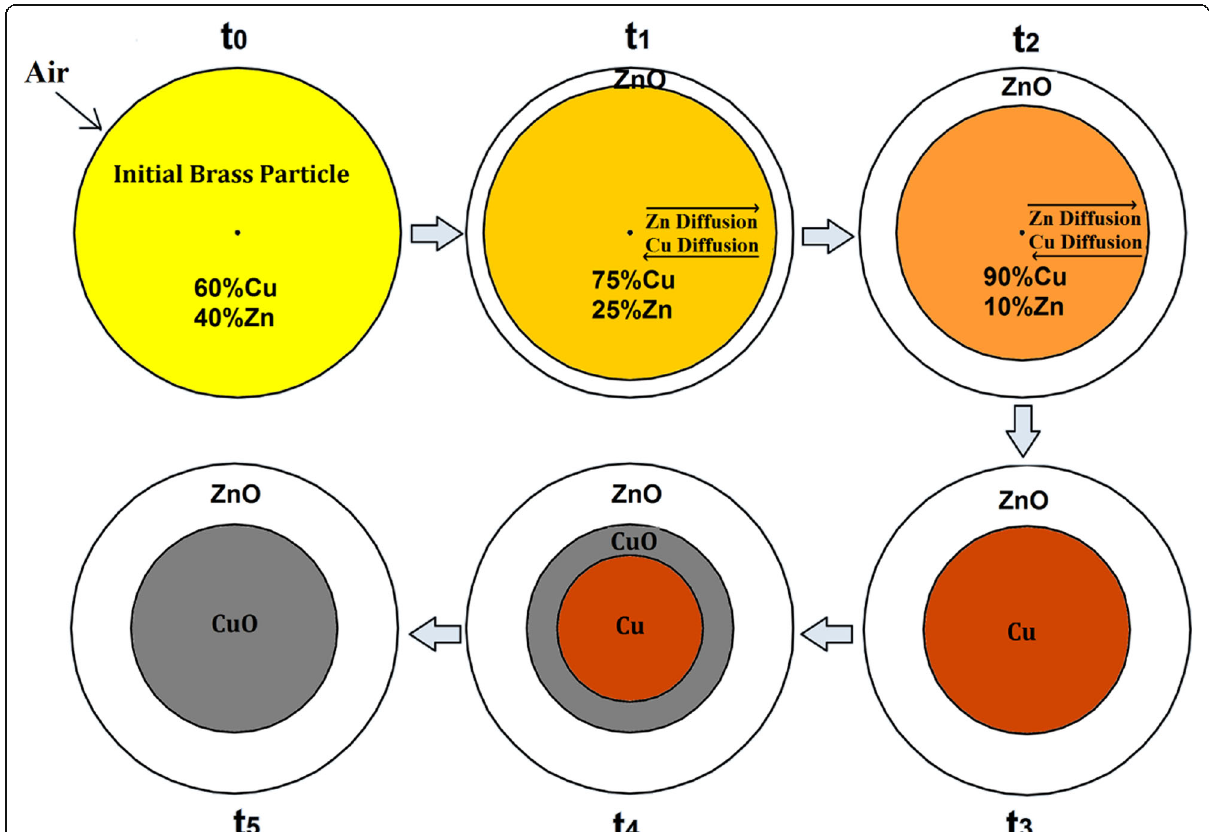
Fig. 4 Schematic representation of oxidation of brass